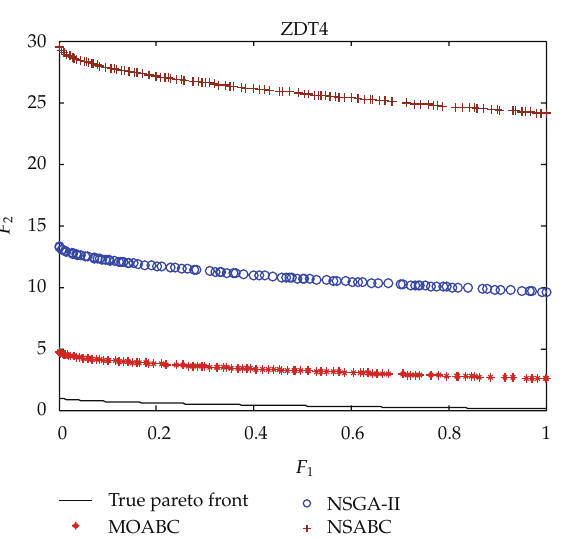
Figure 11: Pareto fronts obtained by NSABC, MOABC, and NSGA-II on ZDT4 after 20000 FEs.